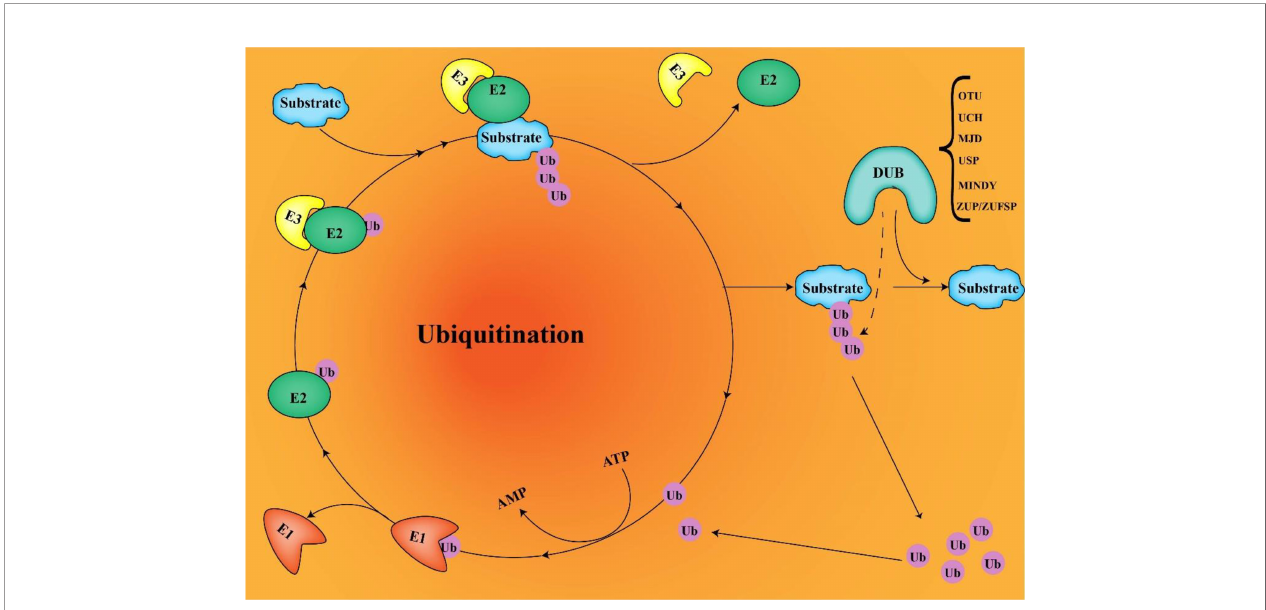
FIGURE 1 | E1, E2, and E3 ubiquitination and DUB deubiquitination (ubiquitin connects to target proteins via E1, E2, and E3. DUB removes ubiquitin from substrates and recovers ubiquitin